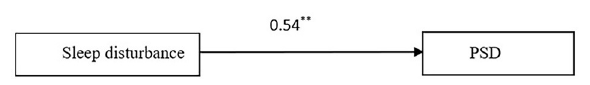
FIGURE 3 | Standardized solutions for the structural equation model of sleep disturbance and PSD. **Indicating the coefficient of the path is significant.